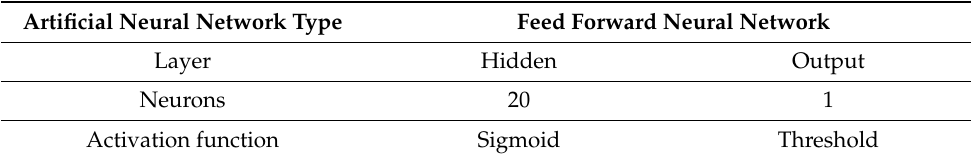
Table 2. Specification of the models that use neural